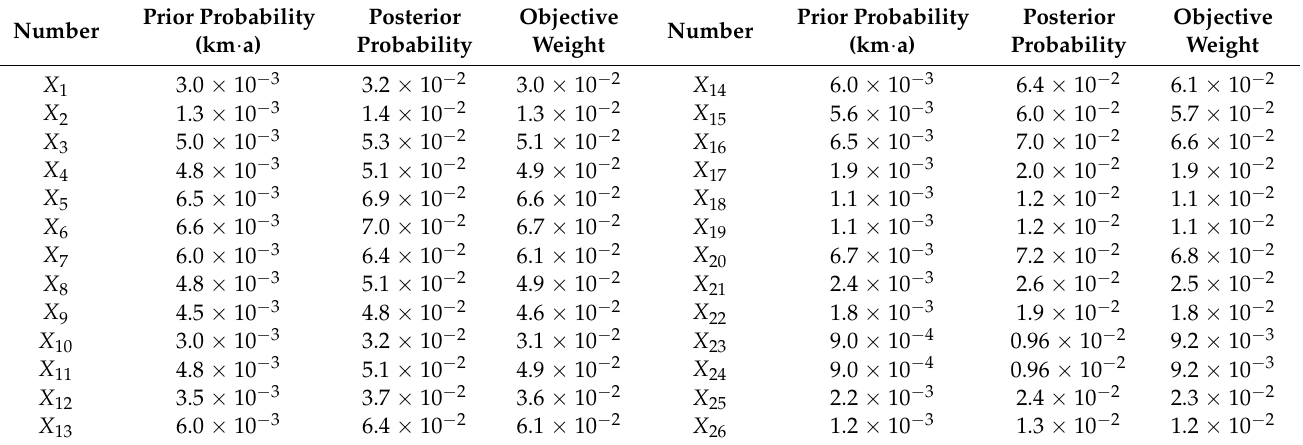
Table 14. Pipe failure factors prior probability, posterior probability, and objective